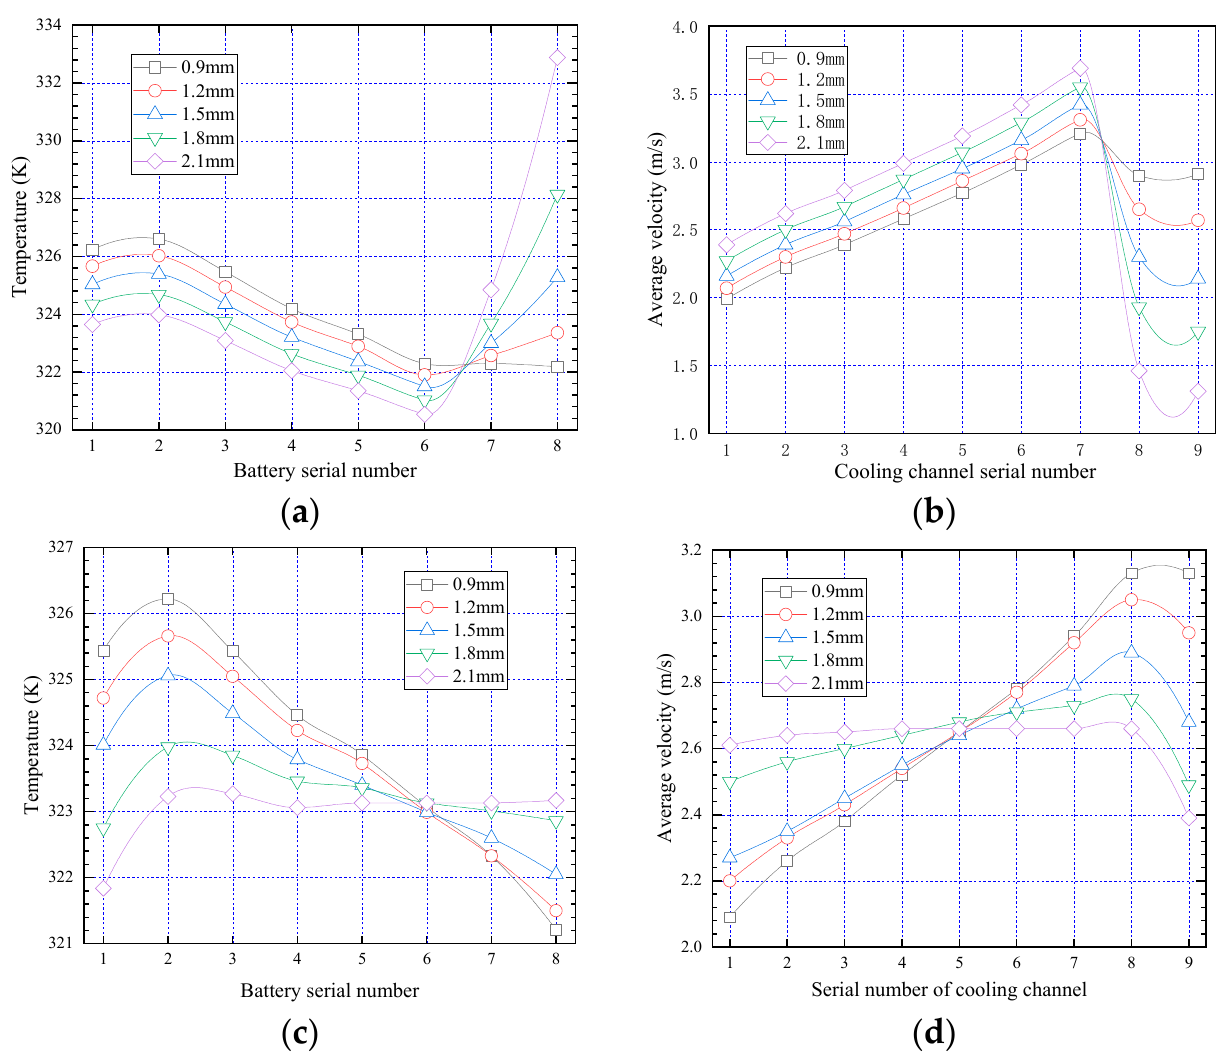
, and Δ P of the battery pack under various lengths of parallel plates; ( a ) cooling performance in case2 Figure 10. T max , Δ T max under various lengths of parallel plates; ( b ) cooling performance in case9 under various lengths of parallel plates.